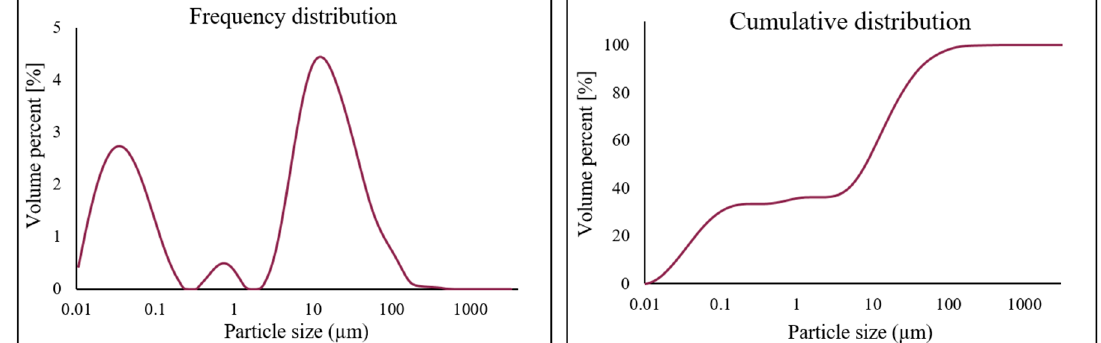
Figure 3. Particle size distribution (PSD) of the EAFD.